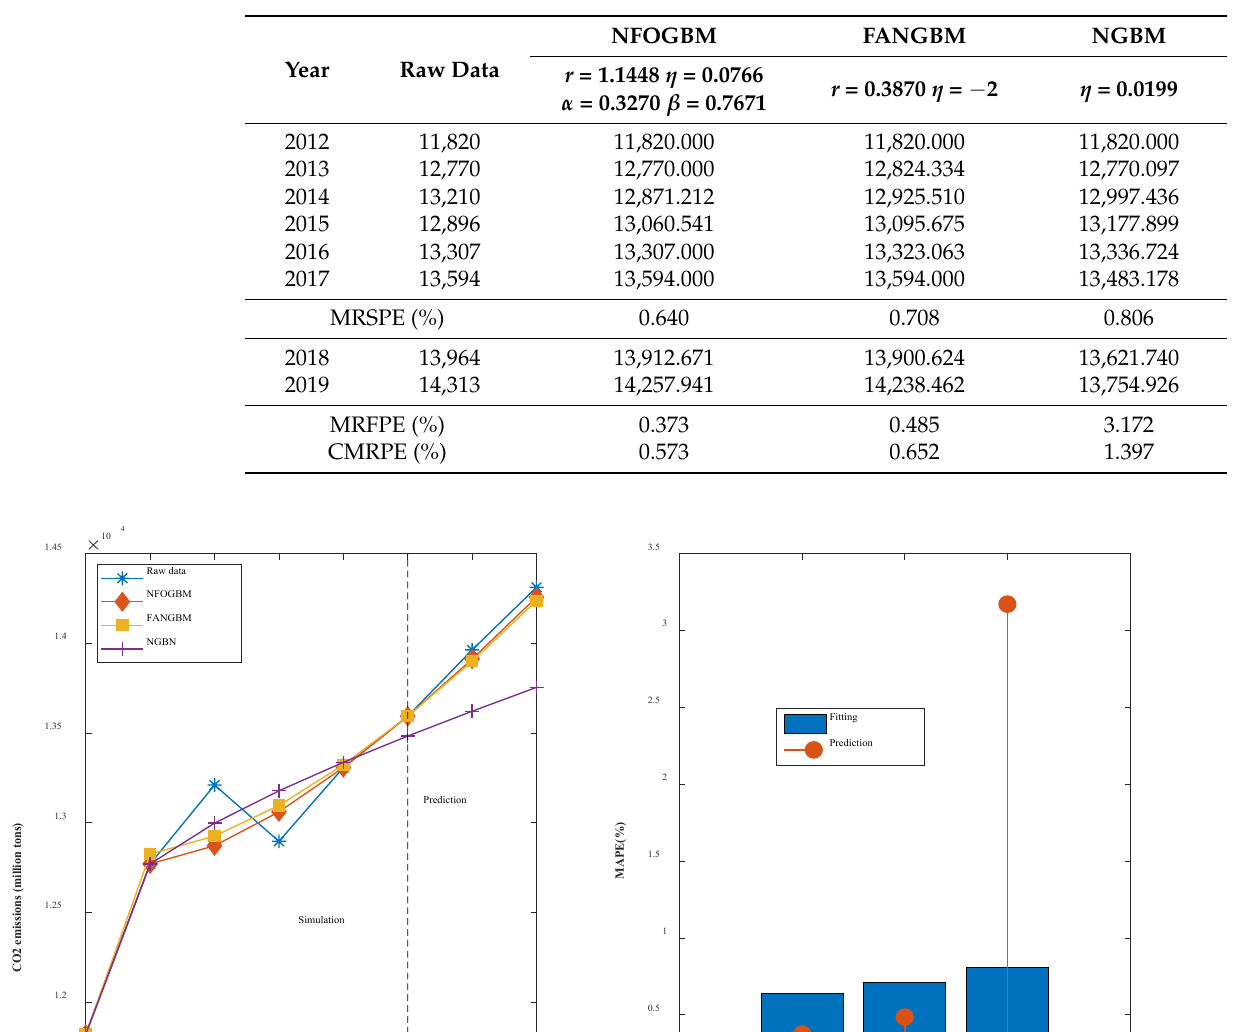
Table 8. Modeling results for PSESH.